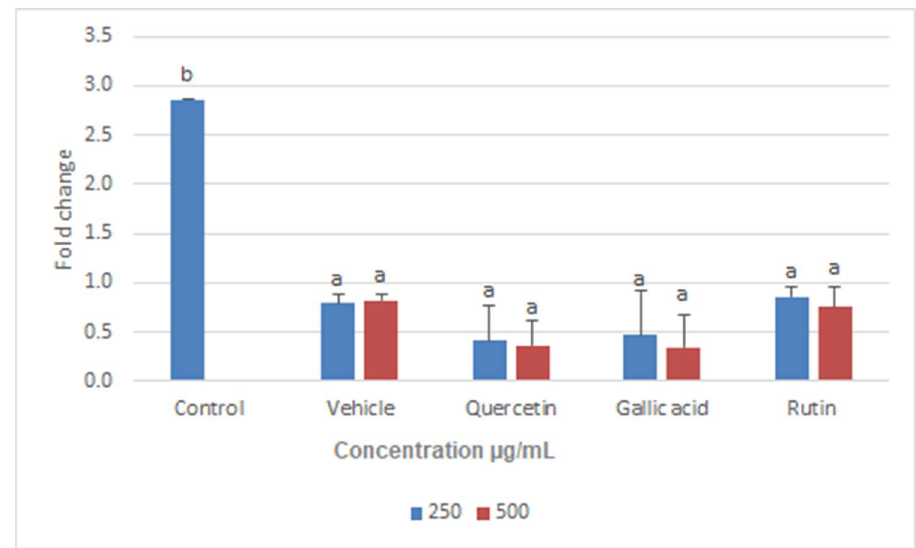
Figure 10. Fold change in expression level of trypanothione reductase enzyme in Leishmania donovani after treatment with two different concentrations (250 µg/mL and 500 µg/mL) of quercetin, gallic acid, and rutin. Data represent the mean values of three replicates with ± standard error. Different labels on columns show significant difference at p < 0.05.